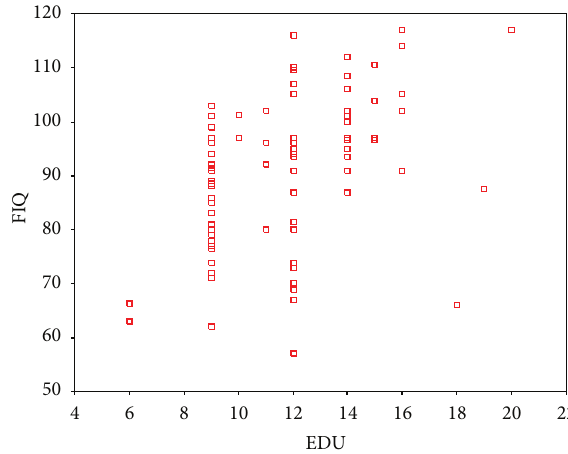
Figure 6: Partial correlation analysis showed a positive relation betweenyearsofeducationandIQ.Correlationcoefficientwas0.448 ( 𝑃 = .000 ).